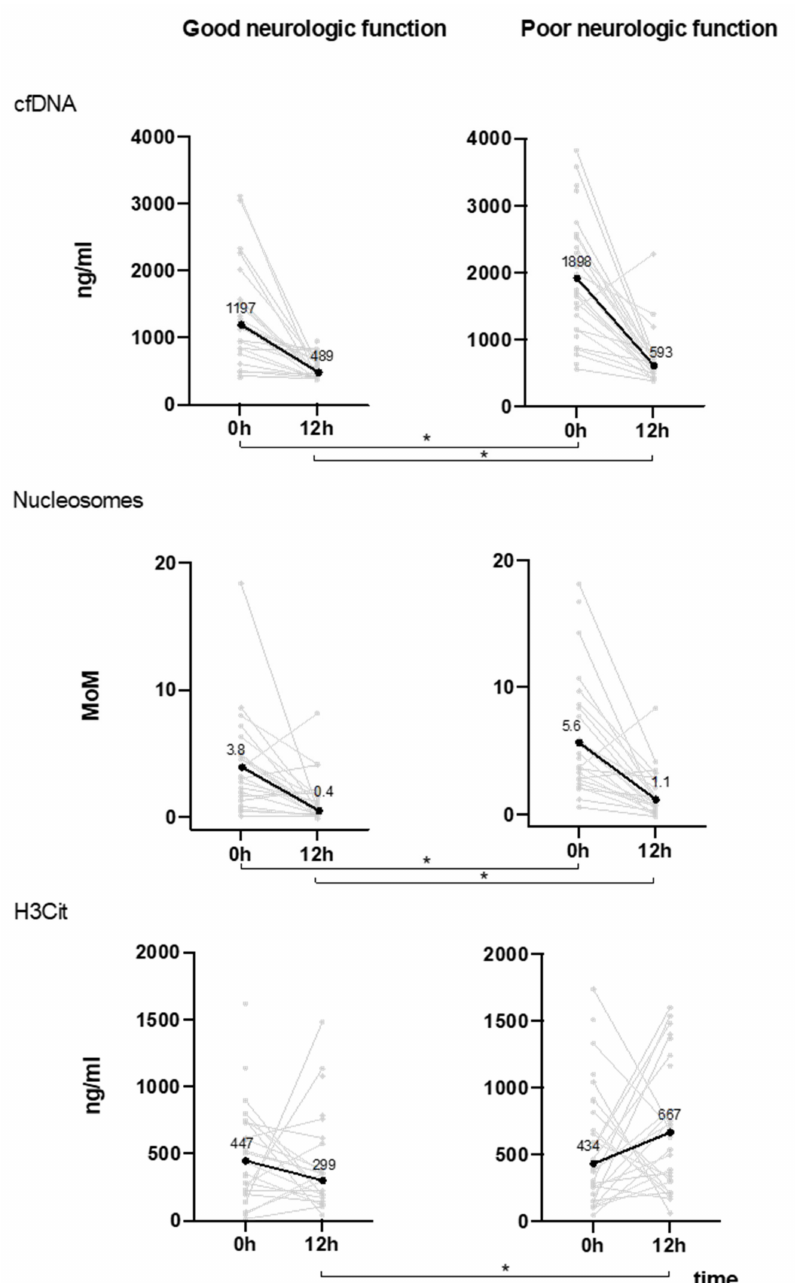
Figure 1. Plasma levels of neutrophil extracellular trap (NET) components ( y -axis) on admission (0 h) and at 12 h ( x -axis) in patients with good (left) and poor (right) 30 day neurologic function. Median levels of cfDNA and nucleosomes decreased in both groups from 0 to 12 h, while median H3Cit levels increased only in patients with poor 30 day neurologic function. Grey lines indicate individual data points, black lines represent median levels of NET-related biomarkers. * indicates significant di ff erence. Individual and median d-dimer levels at 0 h and 12 h in the poor outcome group are available in the Supplementary Materials (Figure